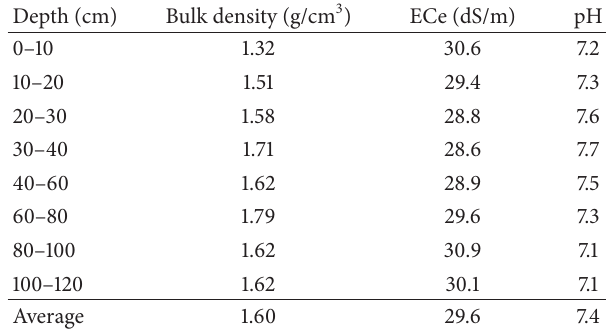
Table 1: Bulk density, electrical conductivity of saturated paste extracts (ECe), and pH of the initial soil profile sampled at Caofeid- ian Eco-city, Hebei,